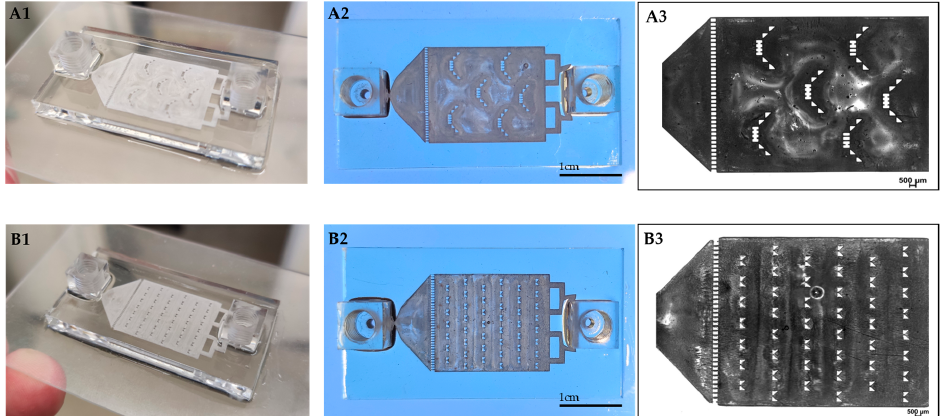
Figure 2. 3D printed drug-release chips containing different interior particle trap designs. “Basket” trap design ( A1 , A2 ) . “V” trap design ( B1 , B2 ) . Bright-field light microscopy image of “basket” ( A3 ) and “V” ( B3 ) shape mechanical